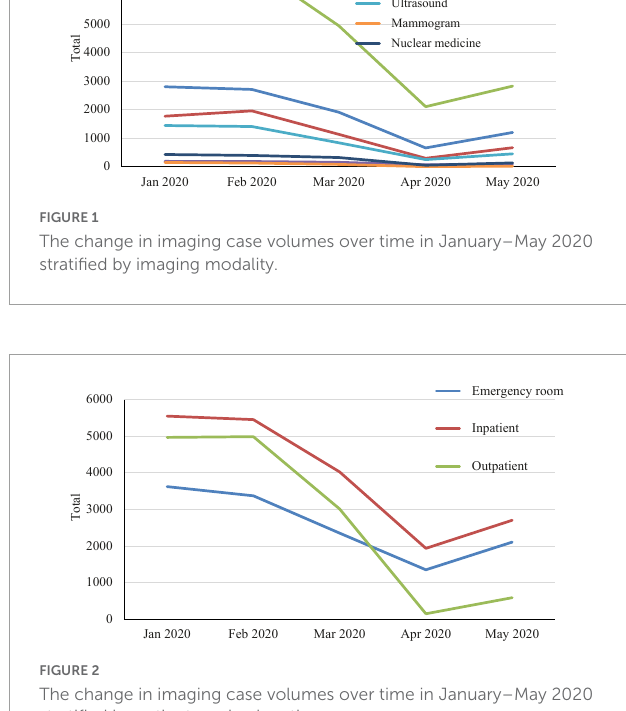
modality and patient service location in the subsequent months during COVID-19. Still, they never reached the imaging case volumes in pre-COVID-19 or in the same time frame for